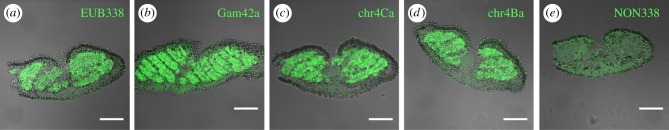
FISH of Kentrophoros sp. H cross-sections with oligonucleotide probes targeting bacterial rRNA. Emission in 508–534 nm channel from fluorophore Alexa 488 (excitation 488 nm) overlaid on transmitted light image. Probes match sequence signatures specific to successively more exclusive groups: (a) EUB338—most Bacteria (positive control), (b) Gam42a—most Gammaproteobacteria, (c) chr4Ca—symbionts of several Kentrophoros species, (d) chr4Ba—symbiont of Kentrophoros sp. H only, (e) NON338—reverse complement of the general bacteria probe (negative control). Scale bars, 25 µm. (Online version in colour.)